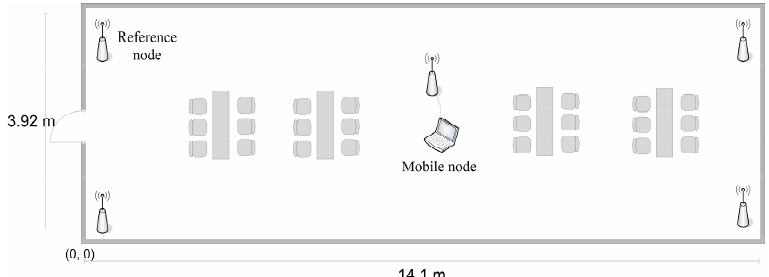
Figure 14. The actual structure of the study room.